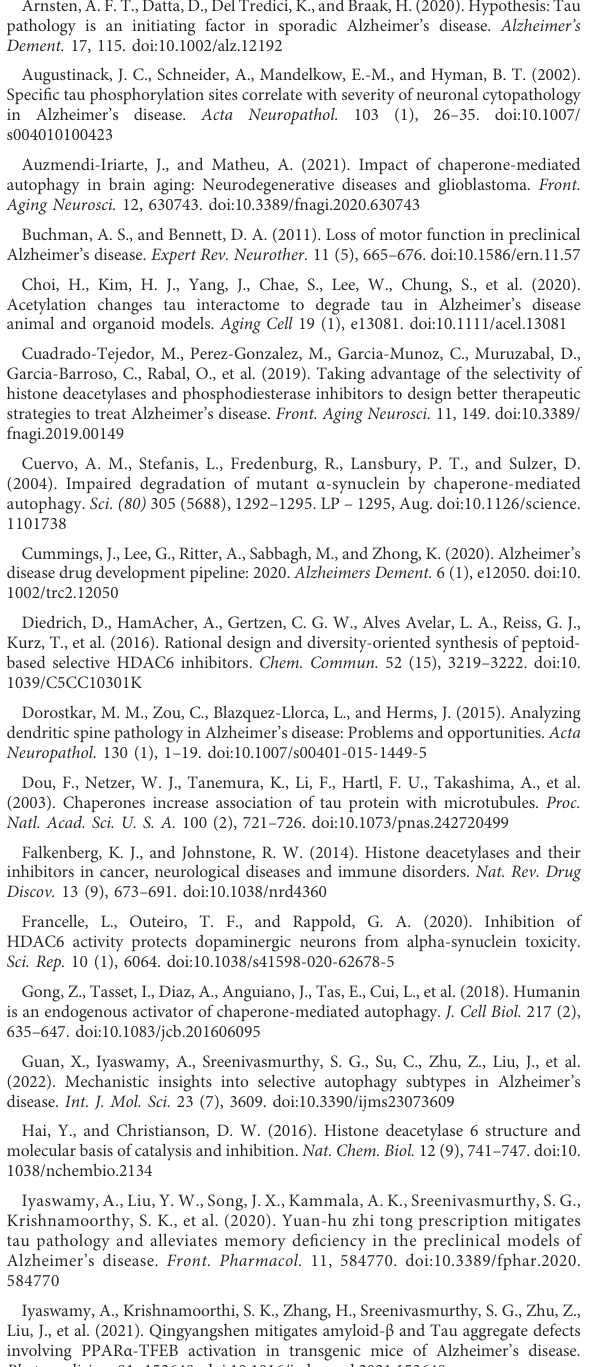
SUPPLEMENTARY FIGURE S6 PRO-Br promoted chaperone-mediated autophagy in-vitro. In N2A cells, (A,B) immuno fl uorescence images show that PRO-Br